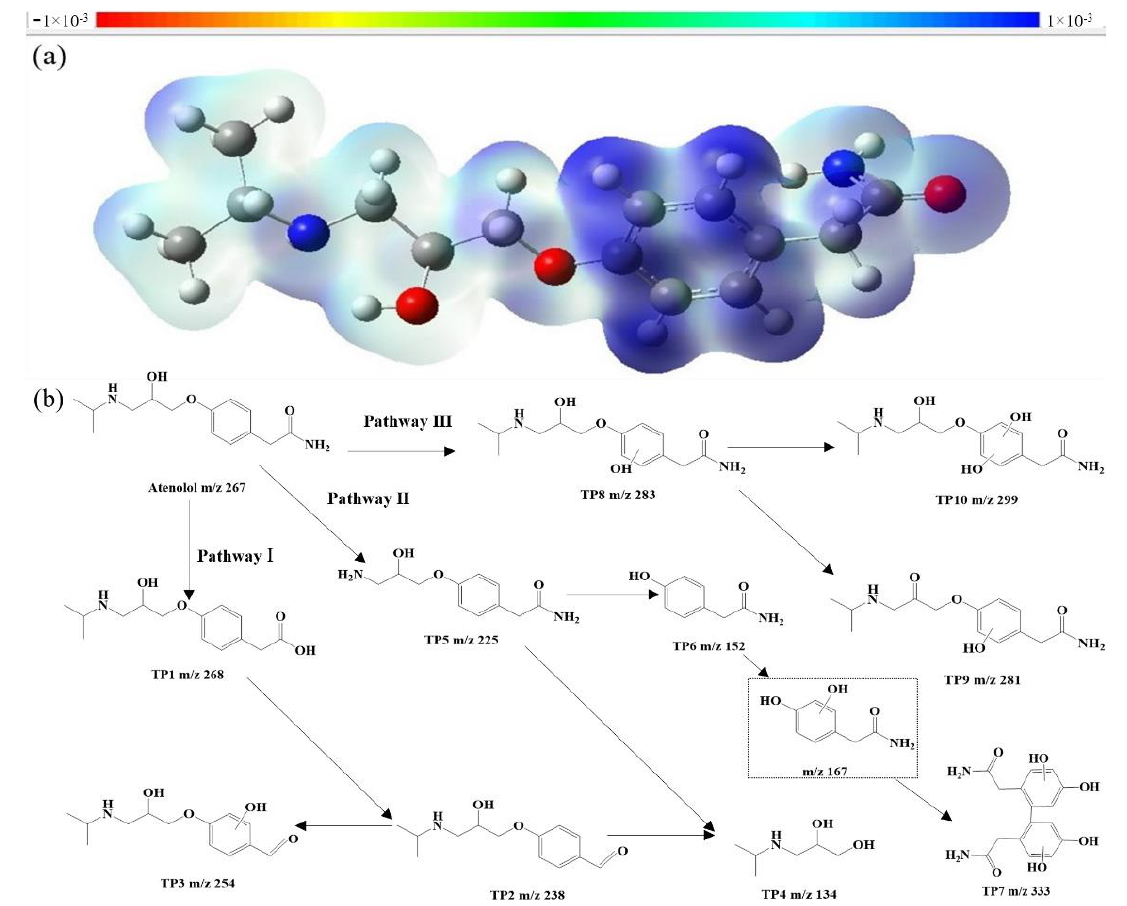
Figure 8. The contour surfaces of Fukui function f 0 for ATL with isovalue of 0.01 ( a ) and the plausible transformation pathways of ATL in UV/PDS process ( b ). Conditions: [ATL] 0 = 0.022 mM, [PDS] 0 = 0.6 mM, pH = 6.0.